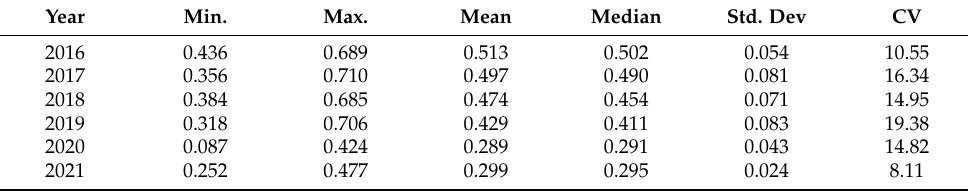
Figure 8. NMDI Soil data vs. time for April–August in different years. Table 4. Descriptive statistics for NMDI Soil data for the month of July (2016–2021). Table 4. Descriptive statistics for NMDI Soil data for the month of July